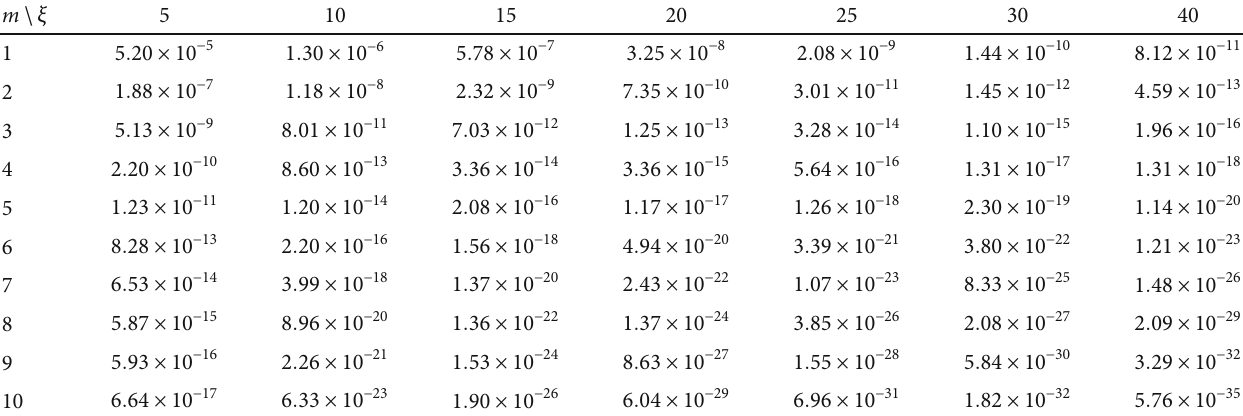
Table 5: Solution error of Θ ð 0, ξ Þ with increase in order of LSPM approximation when Pr = 10 , n = 0 : 5 , K = 0 : 5 , Ω = 0 : 1 , S = 3 , N and He = 0 : 2 .